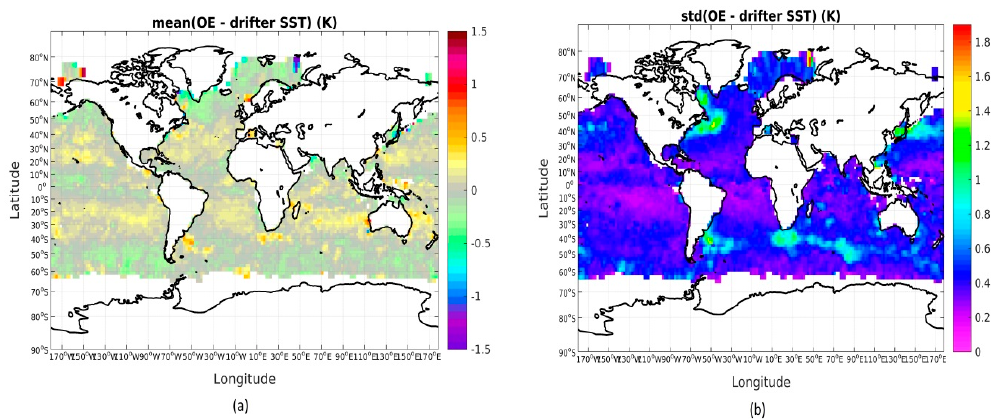
Figure 8. ( a ) Mean OE SST minus drifter SST; ( b ) Mean standard deviation of the OE retrieved minus drifter SST difference. Only retrievals with a corresponding RMSE TB < 0.5 K are plotted in the figures.